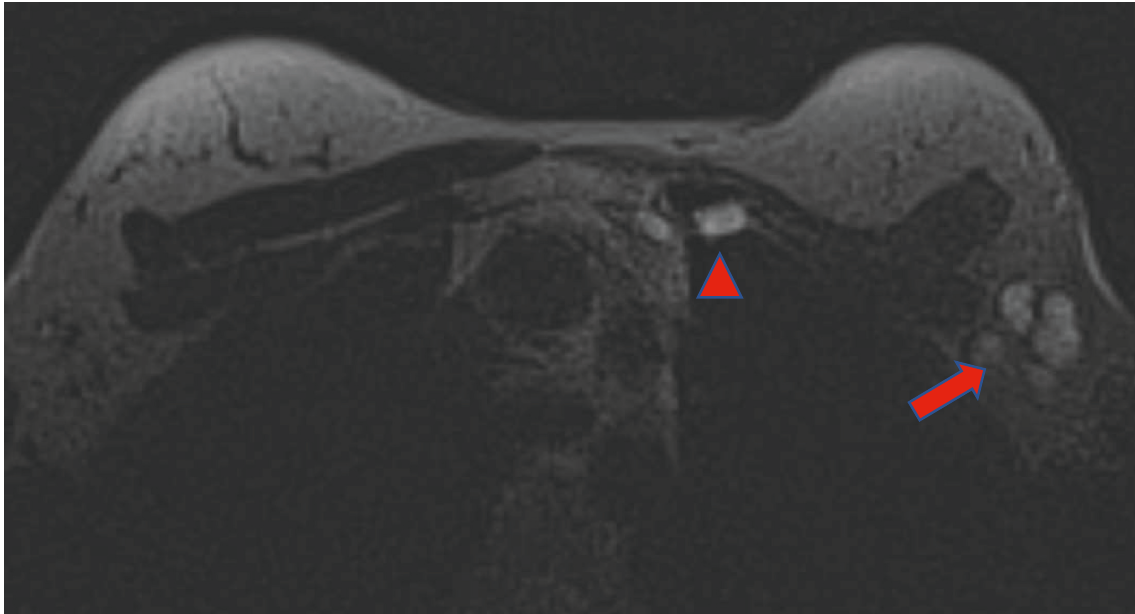
Figure 9: Example of silicone migration in silicone sensitive sequence to the axillary lymph node (red arrow) and internal thoracic (red triangle).